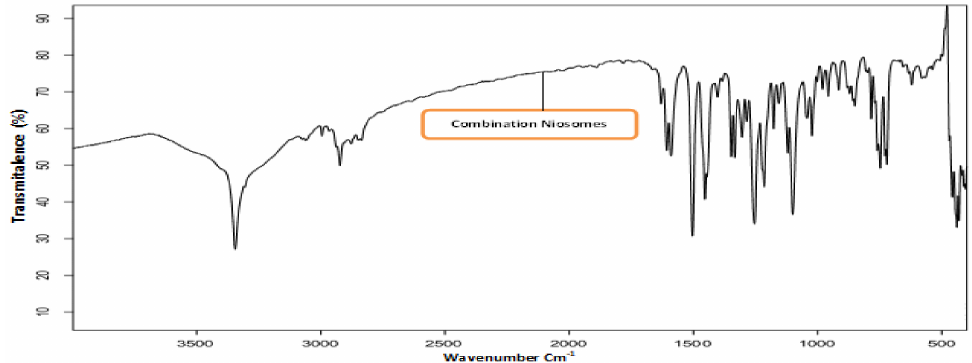
Figure 1. FTIR images of combination acetazolamide and carvedilol optimized transfersomal